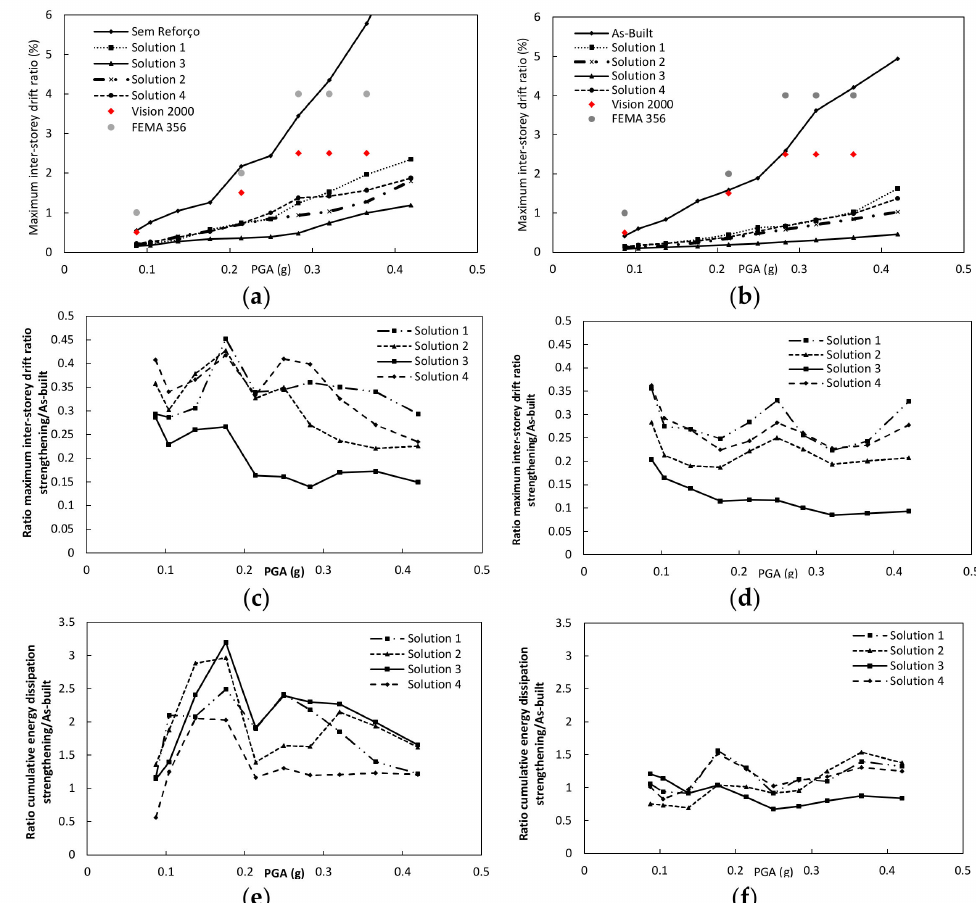
Figure 30. Analysis of the efficiency of the strengthening solutions: ( a ) maximum inter-storey drift ratio (longitudinal direction); ( b ) maximum inter-storey drift ratio (transverse direction); ( c ) ratio between the maximum inter-storey drift (strengthening/as-built) in the longitudinal direction and ( d ) transverse direction; ( e ) ratio between the cumulative energy dissipation (strengthening/as-built) in the longitudinal direction and ( f ) transverse